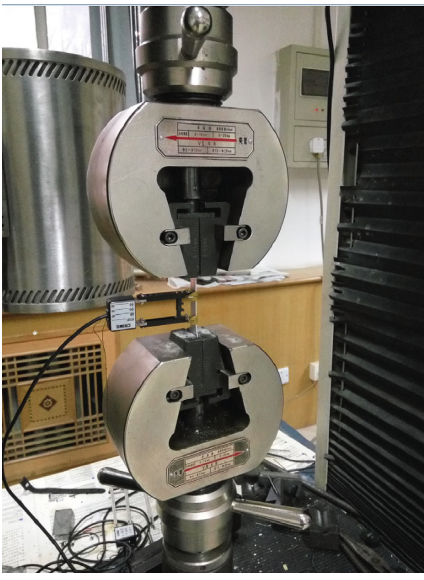
Figure 3: Tension test machine. Table 1: Materials properties of 1060 aluminum.